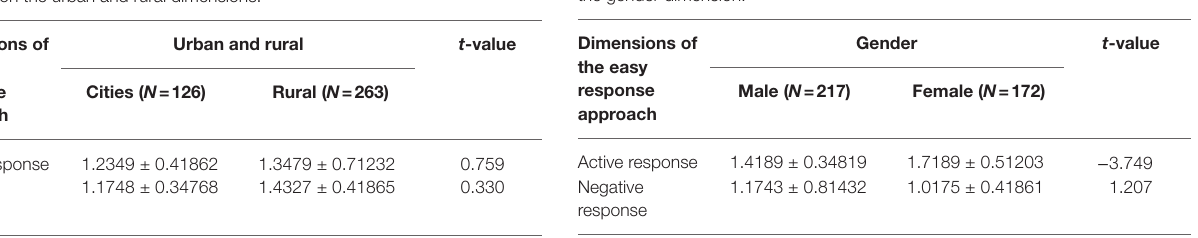
TABLE 3 | Analysis of the differences in coping styles of university students on the gender